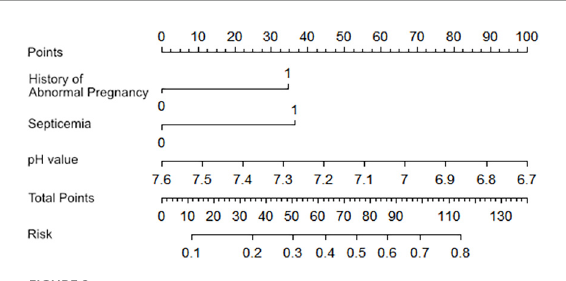
FIGURE2 The nomogram prediction scores of multivariable analysis. The value of each variable was given a score on the point scale axis. A total score could be easily calculated by adding each single score, and by projecting the total score to the lower total point scale, we were able to estimate the probability of early death among newborns with